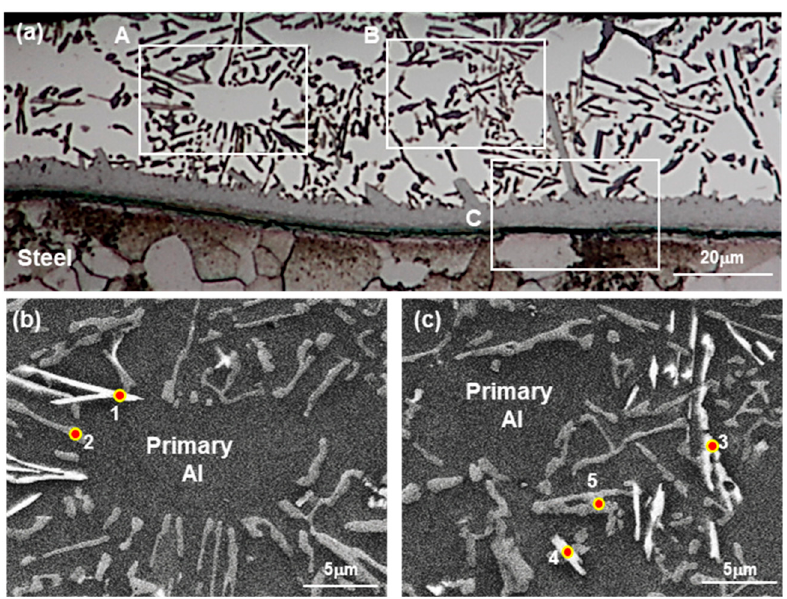
Figure 1. ( a ) Optical microstructure; ( b , c ) SEM structures of the areas denoted as A and B in ( a ).